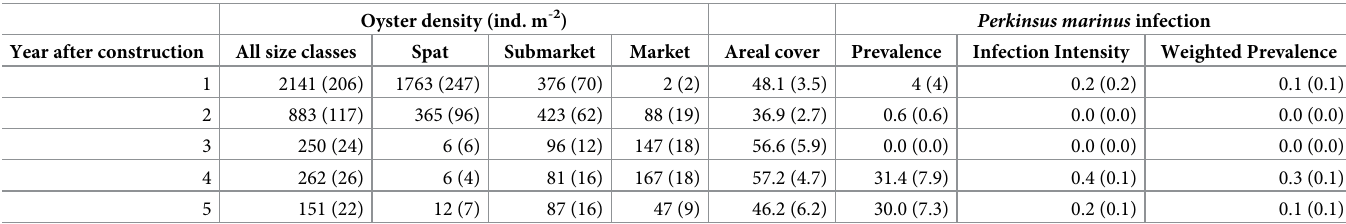
Table 1. Annual mean (SE) oyster density, percent areal coverage by oysters, and P. marinus infection in years 1, 2, 3, 4, and 5 years after reef construction. Oyster density (ind. m -2 ) Perkinsus marinus infection Year after